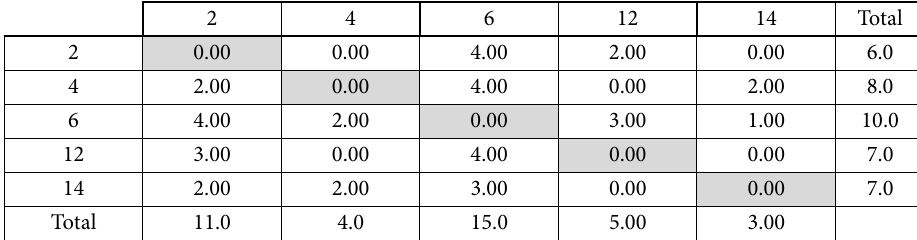
Table 3. Direct influence matrix for C1 Physical Space